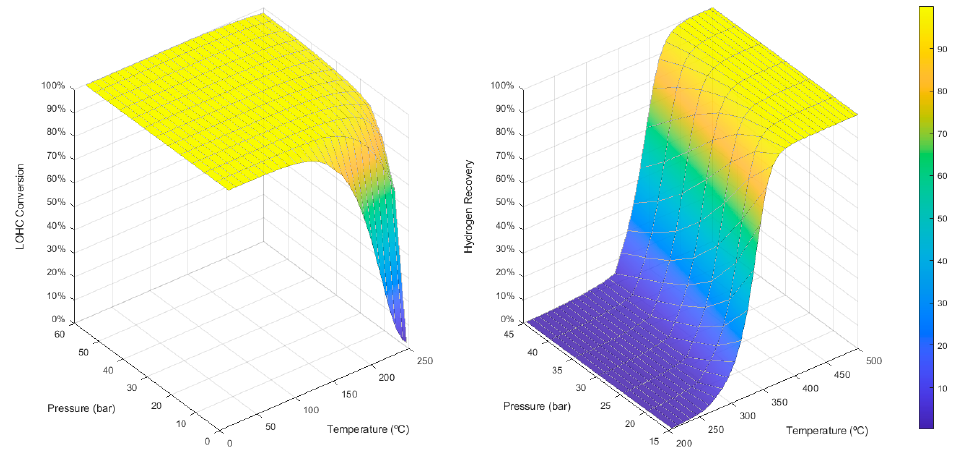
Figure 14. LOHC reactor conditions optimization results: the hydrogenation process ( left ) and the dehydrogenation process ( right ).